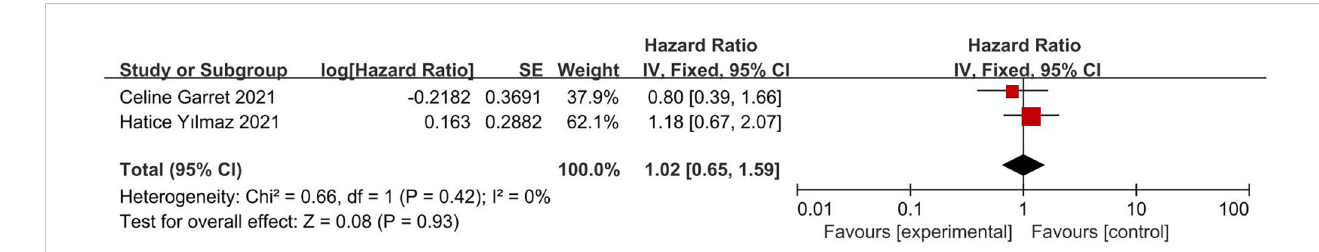
FIGURE 5 Forest plot of correlation between PNI score and PFS in multivariate analysis data.